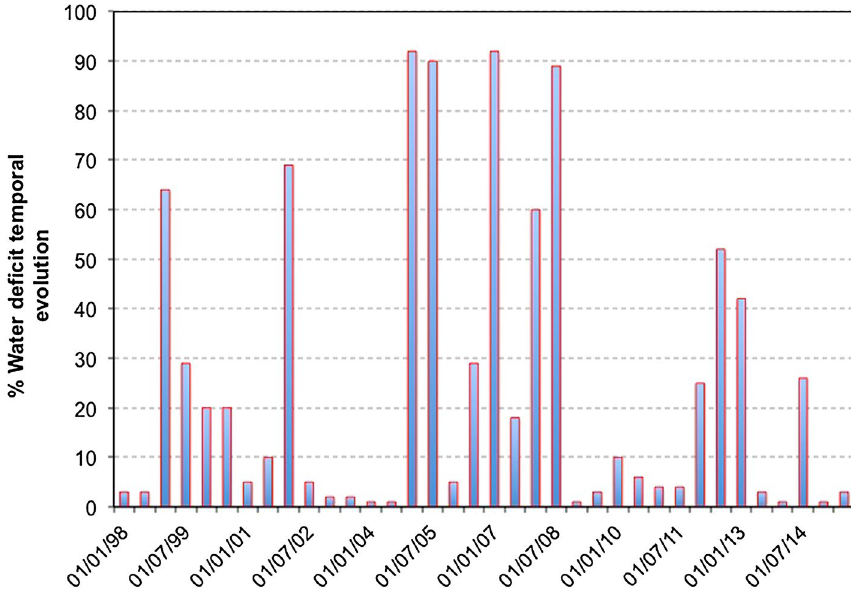
Fig. 2 Water deficit